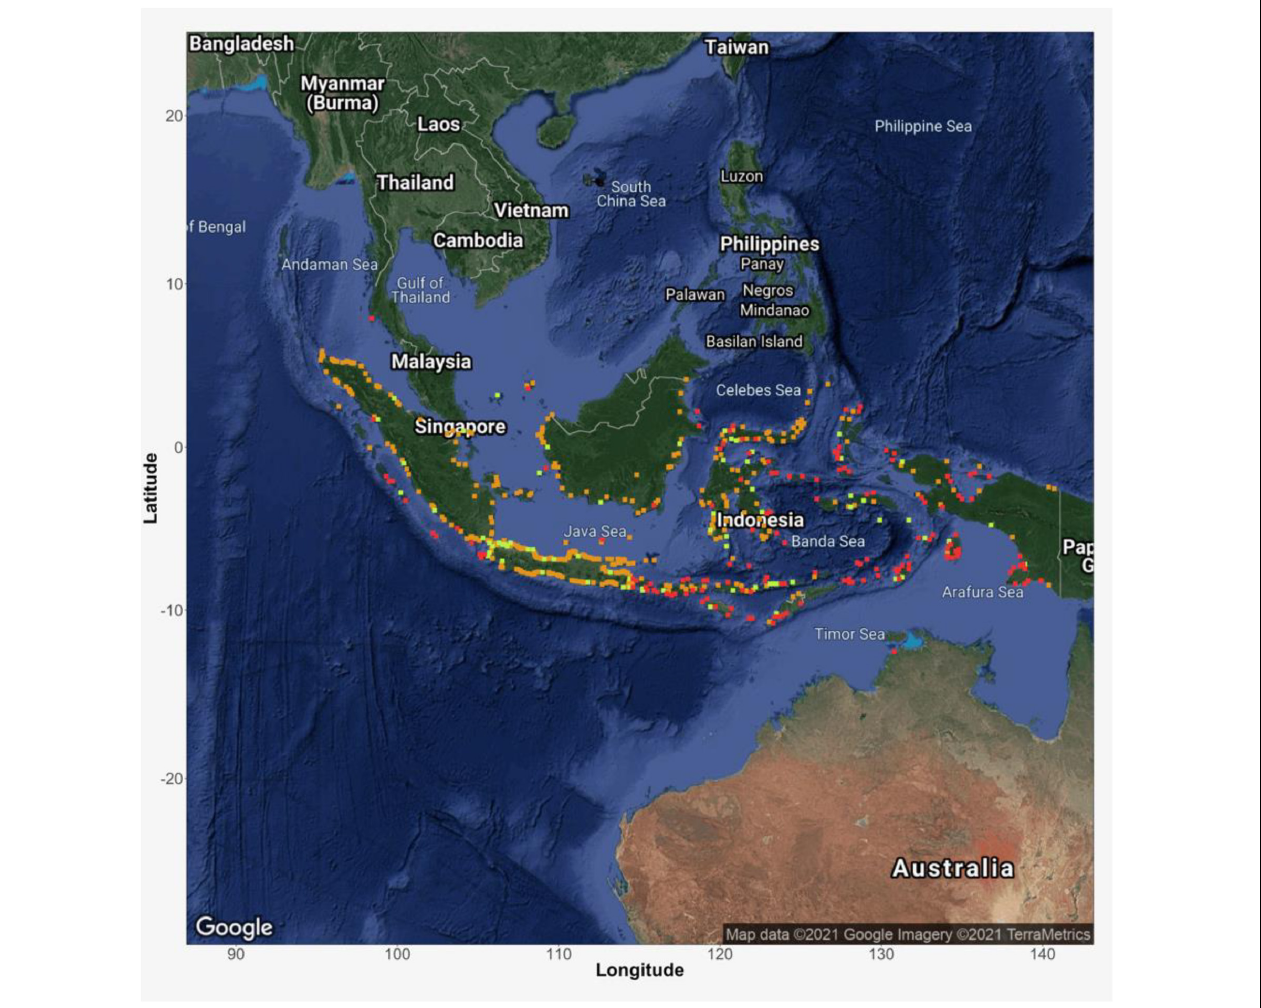
FIGURE 3 | Map of identified ports vs. registered ports. Green squares indicate identified landing sites based on VMS data that match one (or more) officially registered ports; oranges squares indicate landing sites based on VMS data that did not match any officially registered port and red squares indicate registered ports that were not visited by longline fishing